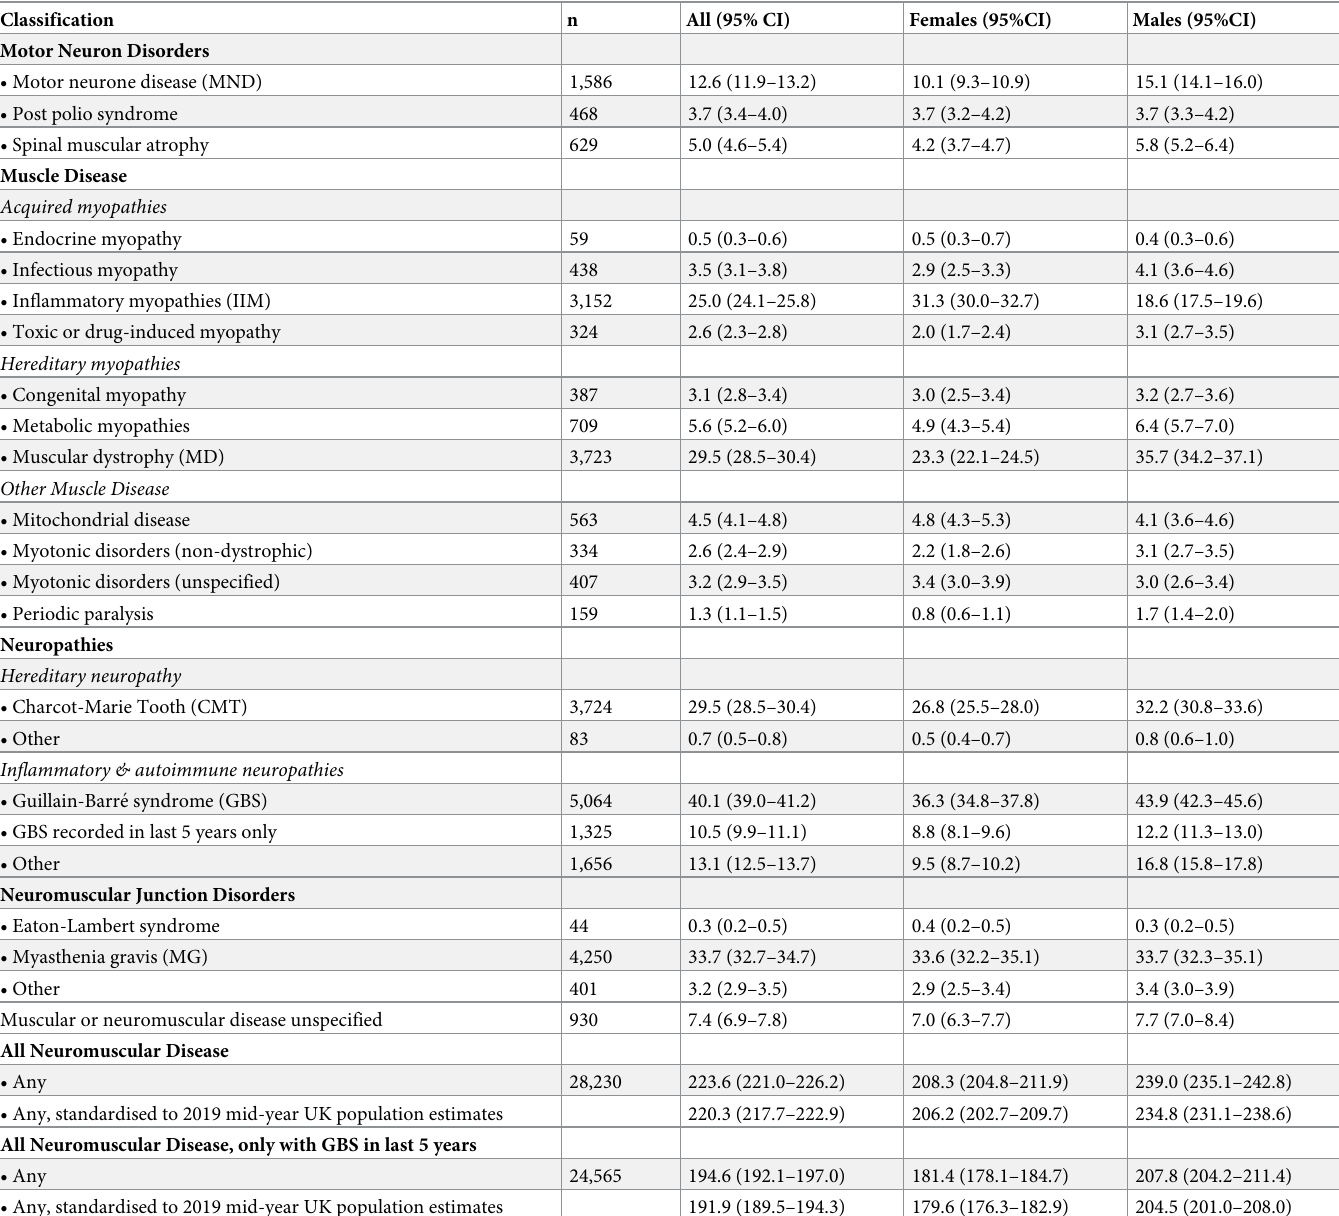
Table 2. Prevalence of recorded neuromuscular disease in the UK on